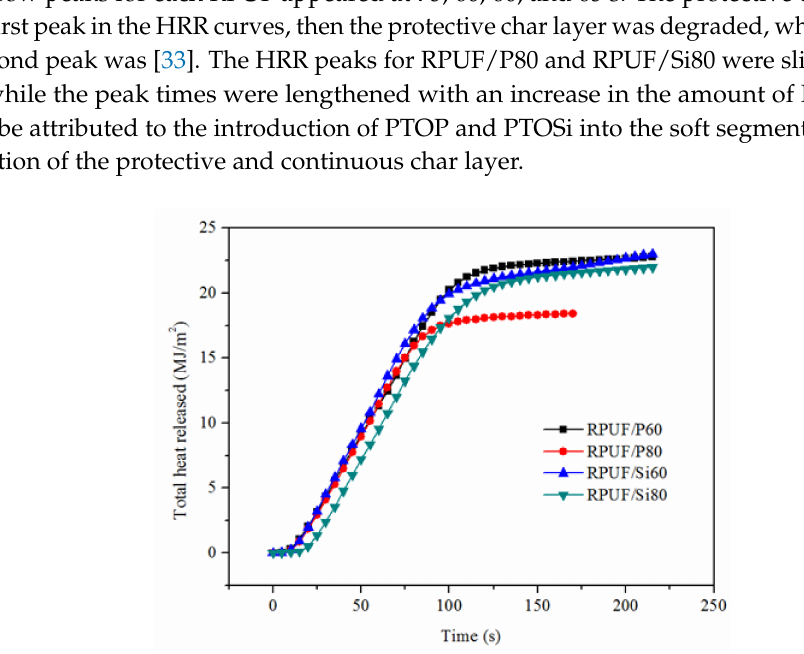
Figure 10. Heat release rate (HRR) curves of